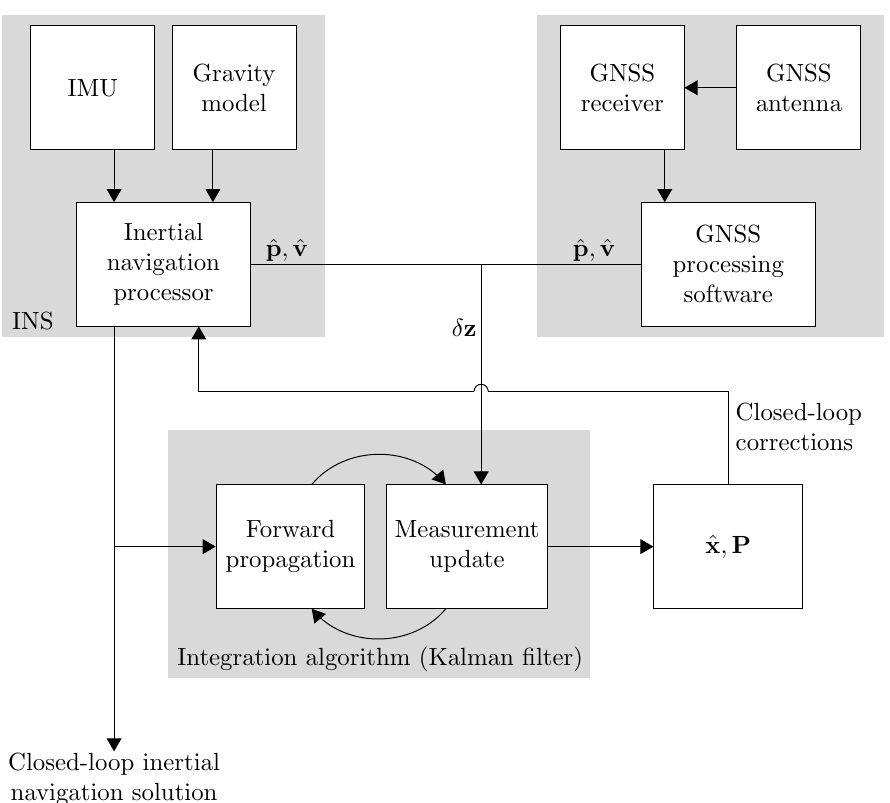
Figure 3. Overview of processing and data integration